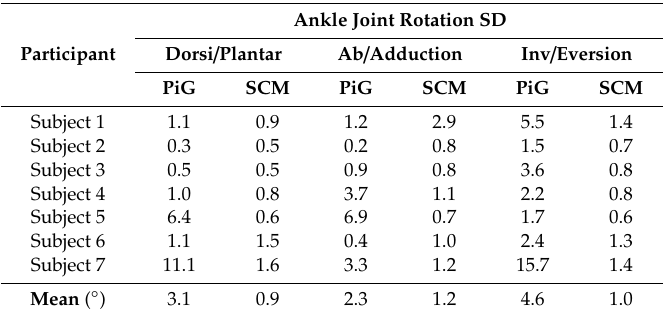
Table 5. Within-subject variability of ankle joint rotation over the amputated gait cycle across three trials per participant as calculated by PiG and SCM is shown by the standard deviation, SD.